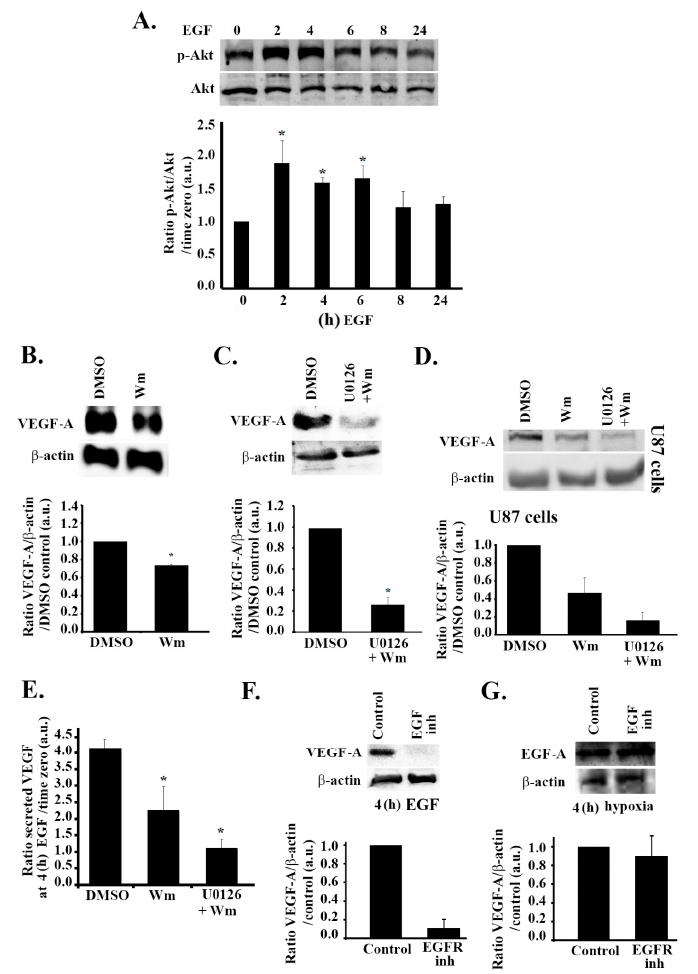
Figure 5. EGF stimulation leads to an increase in VEGF expression and secretion through PI3K and ERK in parallel to hypoxia. ( A ) SF-268 cells were starved in serum-free media for 3 h, then stimulated with 15 nM EGF for the indicated times. Cells were then lysed, and the lysates were blotted for p-Akt and Akt. The graph is a densitometric analysis of the Western blots using Image J. Values are normalized to Akt and expressed as fold change compared to time zero ( − EGF). (B / C) SF-268 cells were treated with either DMSO alone or Wm (100 nM) ( B ) or with DMSO alone or U0126 (50 µ M) + Wm (100 nM) ( C ). Cells were then treated with 15 nM EGF for 4 h (treatment detailed in Section 2) and lysed, and cell lysates were blotted for VEGF-A or β -actin for loading control. The graphs are quantitations of the VEGF bands normalized to actin and expressed as fold change compared to control (DMSO). ( D ) U87 cells were treated with either DMSO alone or Wm (100 nM) or U0126 (50 µ M) + Wm (100 nM), treated with 15 nM EGF for 4 h (treatment detailed in Section 2), and lysed, and cell lysates were blotted for VEGF-A or β -actin for loading control. The graphs are quantitations of the VEGF bands normalized to actin and expressed as fold change compared to control (DMSO). ( E ) Supernatants from SF-268 cells treated with DMSO alone, Wm alone, or Wm + U0126 and then treated with EGF for 4 h (after 3 h starvation) were collected and measured for VEGF-A secretion according to the manufacturer’s guidelines. Values are expressed as fold change at every treatment to time zero ( − EGF). ( F ) SF-268 cells were treated with 10 µ M EGFR inhibitor AG1478 or left untreated, and then treated with EGF for 4 h. Cells were then lysed and blotted with anti-VEGF-A and anti- β -actin. The graph is a quantitation where the values were normalized to actin and expressed as fold change compared to control ( − AG1478). ( G ) SF-268 cells were treated with 10 µ M EGFR inhibitor AG1478 or left untreated and then subjected to 4 h hypoxia, or left in normoxia. Cells were then lysed and blotted with anti-VEGF-A and anti- β -actin. The graph is a quantitation where the values were normalized to actin and expressed as fold change compared to control ( − AG1478). The data are means ± SEM from three di ff erent experiments; * p < 0.05 indicates statistically significant di ff